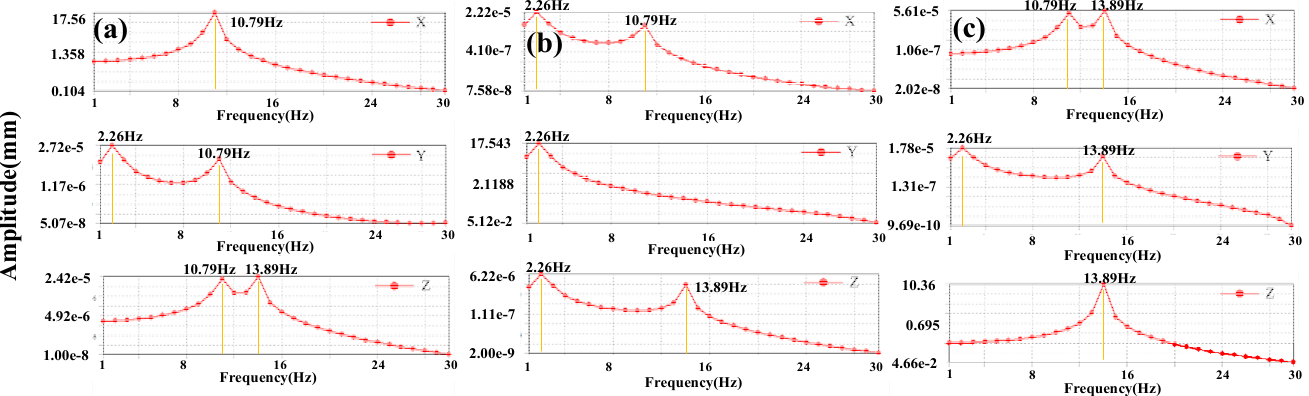
Figure 4. The deformations from harmonic response analysis when the U-shaped structure excited by ( a ) x-axis, ( b ) y-axis, and ( c ) z-axis accelerations. Concerning the FEA results, the first three modes, namely operating modes of pro- posed PVEH, correspond to the bending deformation of upper beams, first horizontal mode and vertical mode of conventional U beam, respectively. Thus, the improved U-shaped structure can be divided into two parts to derive the formulas for its working